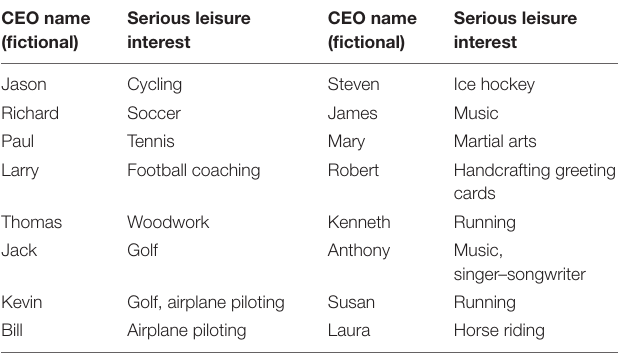
TABLE 1 | Interviewed CEOs and their serious leisure